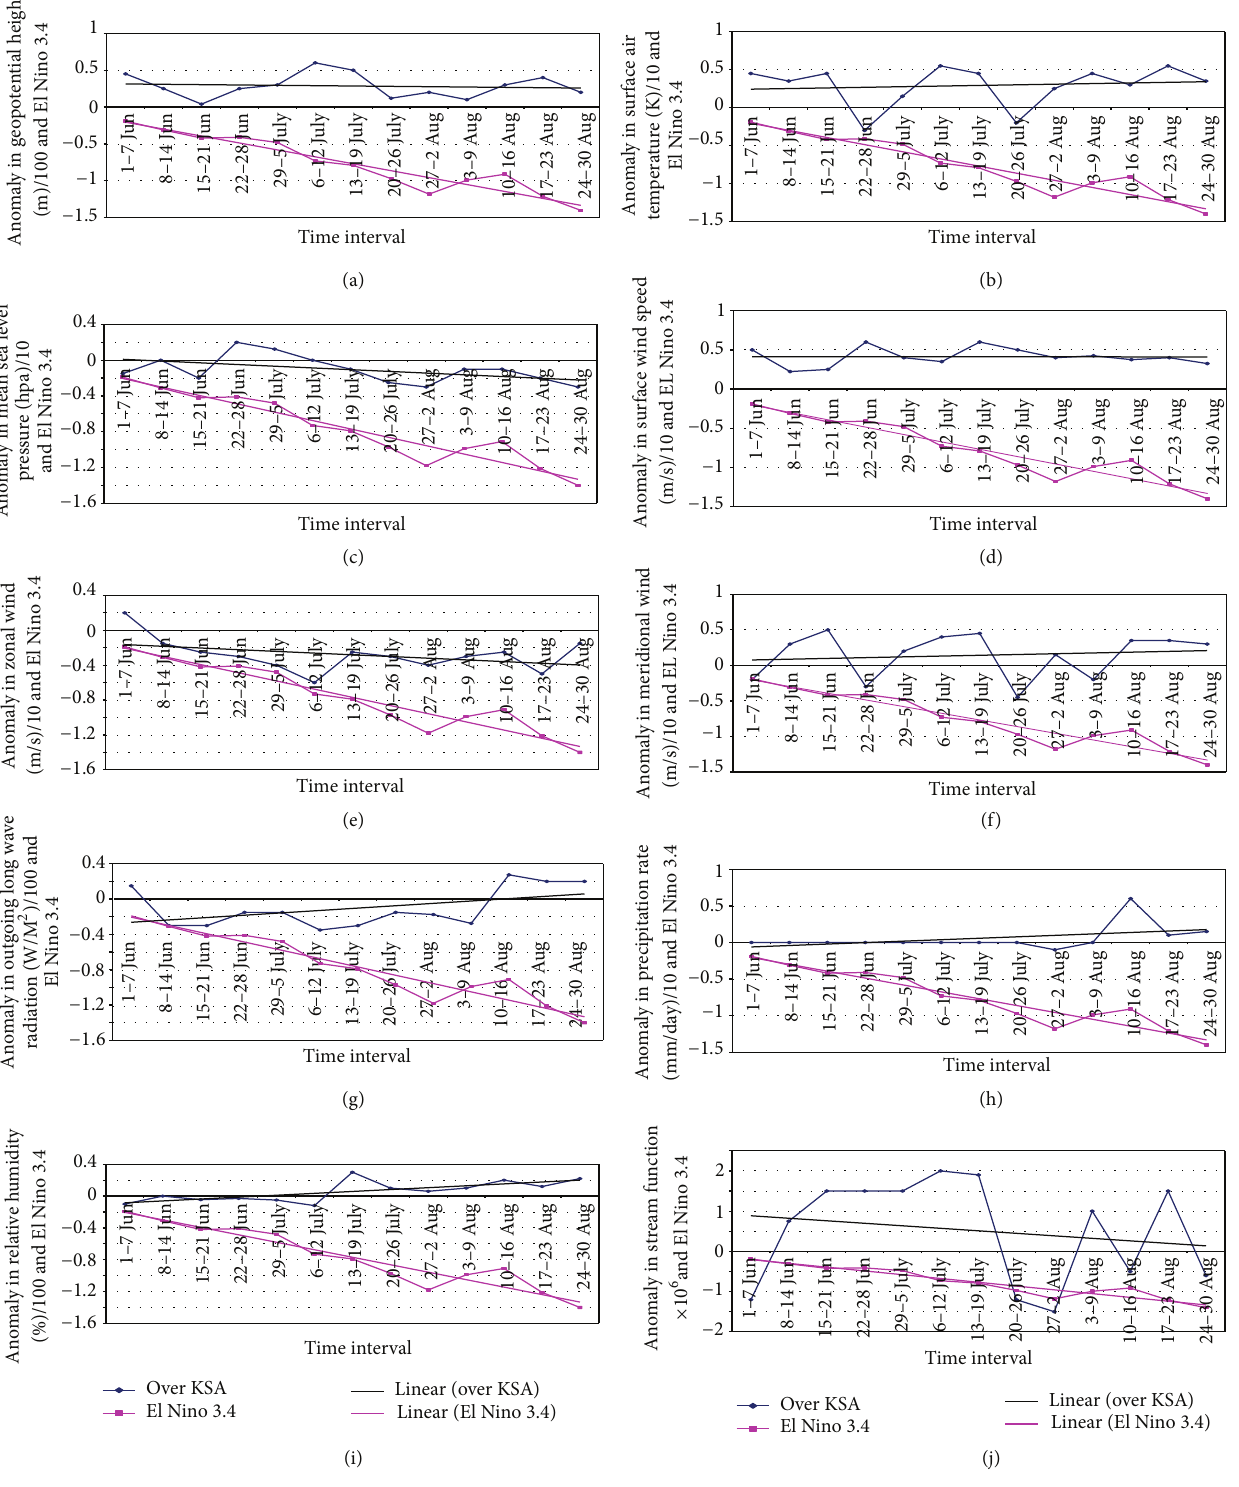
Figure 10: Time series analysis—7 days—of anomaly of the El-Nino3.4 and anomaly of weather elements over KSA during the summer season